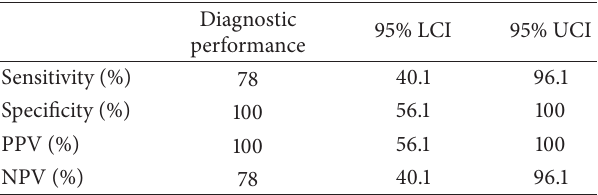
LCI:lowerlimitofthe95percentconfidenceinterval;UCI:upperlimitofthe 95percentconfidenceinterval;PPV:positivepredictivevalue;NPV:negative predictive